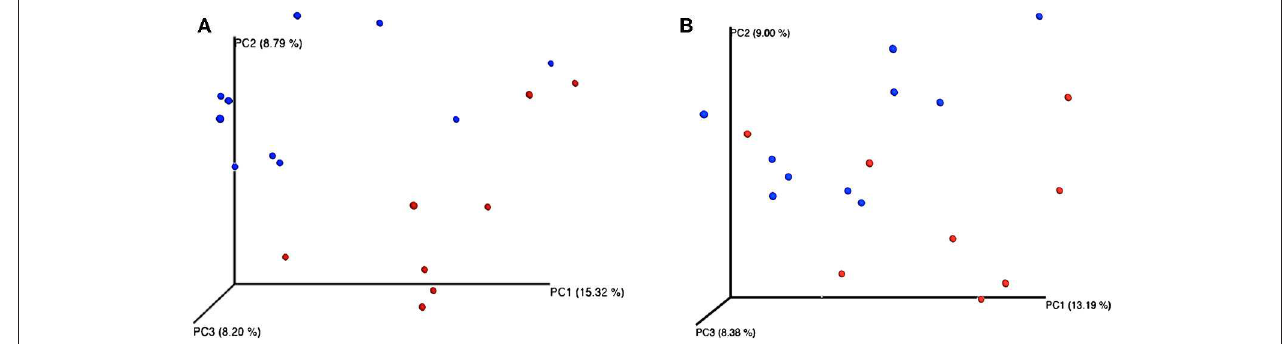
FIGURE 3 | Principal coordinates analysis (PCoA) representing β -diversity of both fecal (A) and nasal (B) bacterial communities in dairy calves. Figures were computed using unweighted Unifrac distances and a depth coverage of 17,300 sequences per sample. Bacterial communities from calves fed milk replacer (MR) ( n = 8) are depicted in red, and those from calves fed pasteurized waste milk (pWM) ( n = 10) in blue.